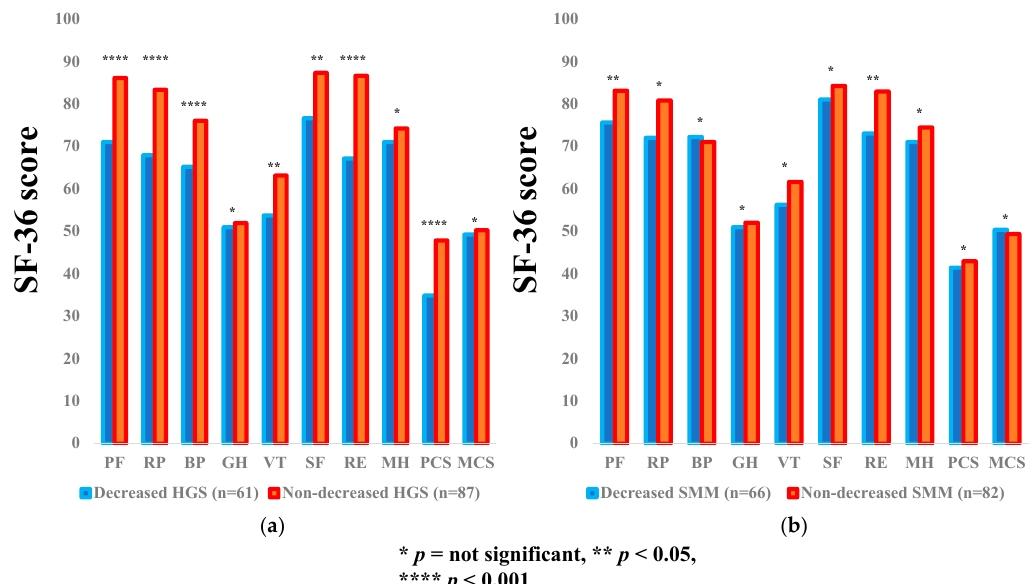
Figure 2. The SF-36 scores across 10 items in the decreased and non-decreased HGS groups ( a ), and the decreased and non-decreased SMM groups ( b ) in LC patients ( n = 148). The average scores in each item of the SF-36 were